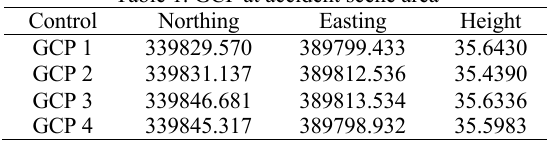
Table 1. GCP at accident scene